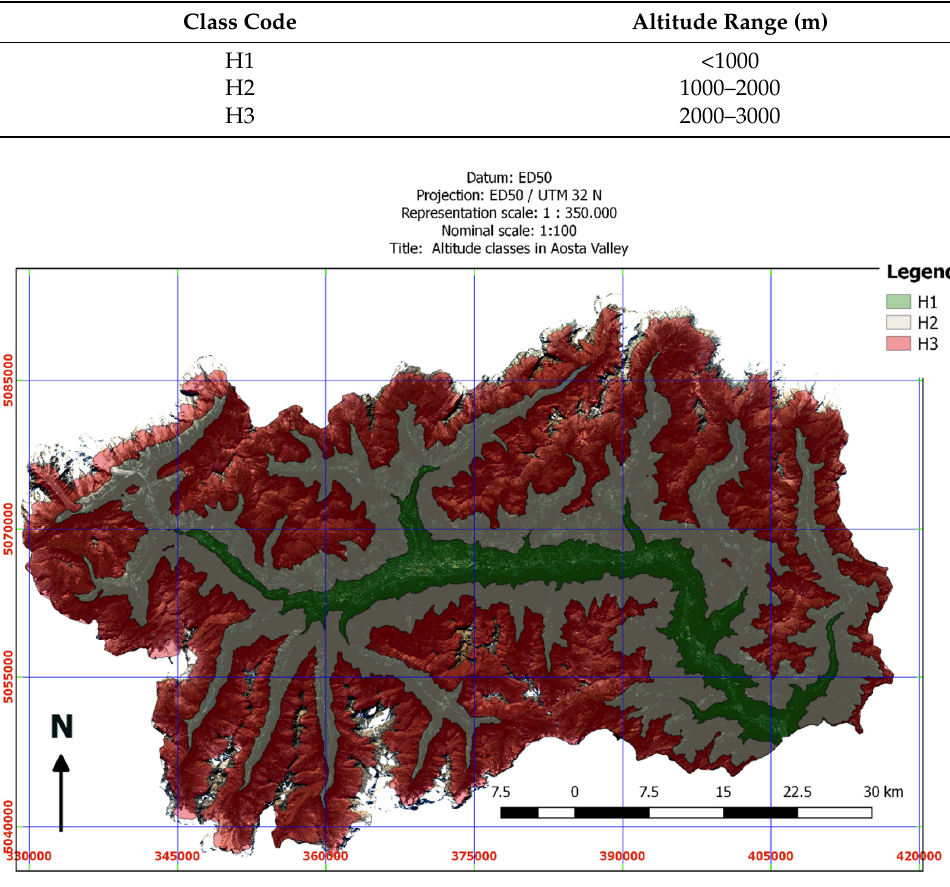
Figure 3. Aosta Valley height classes: H1, H2, H3.